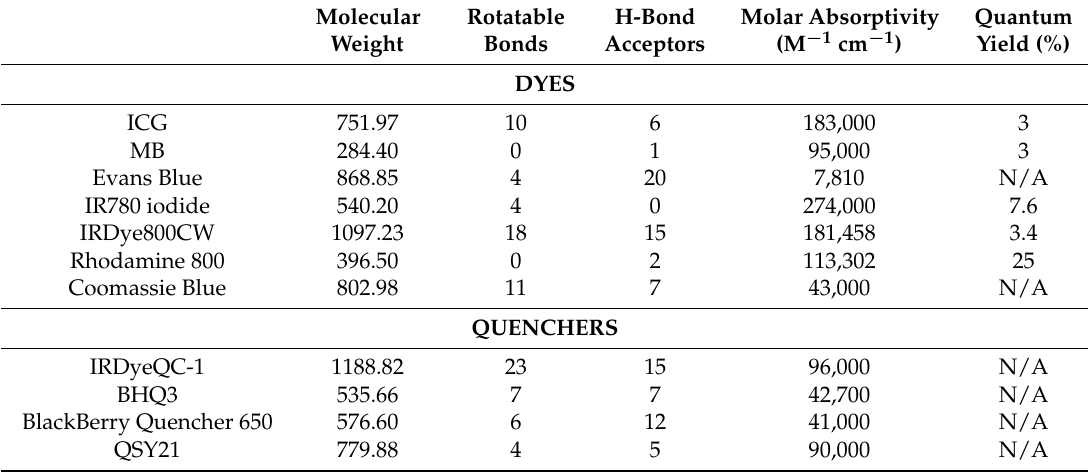
Table 1. Observable/Experimental physicochemical properties of selected dyes and quenchers. Molecular Weight